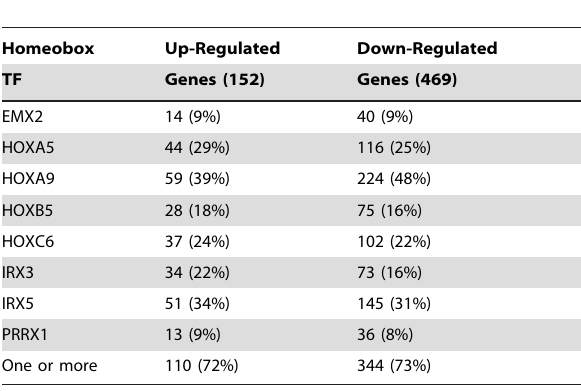
Table 5. Validation of selected genes by qPCR. Fold change (Post/Pre)